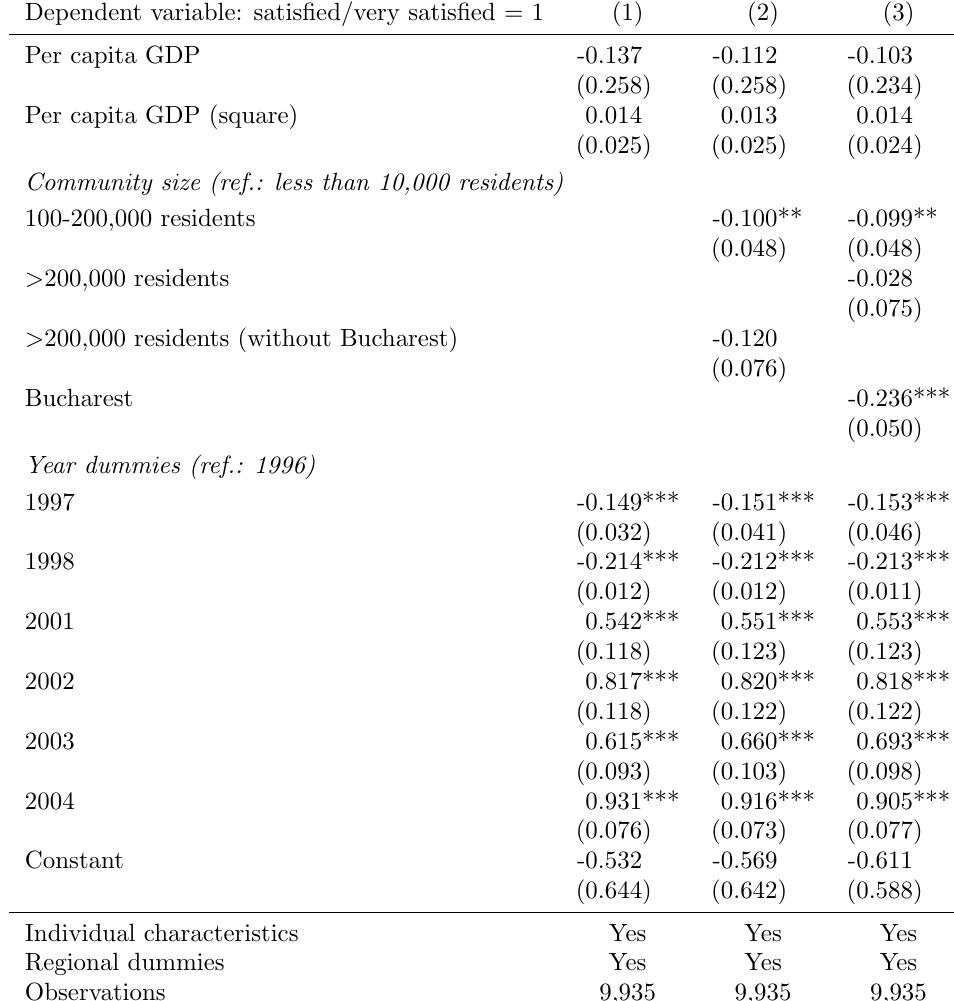
Table 3: Life satisfaction and city size: